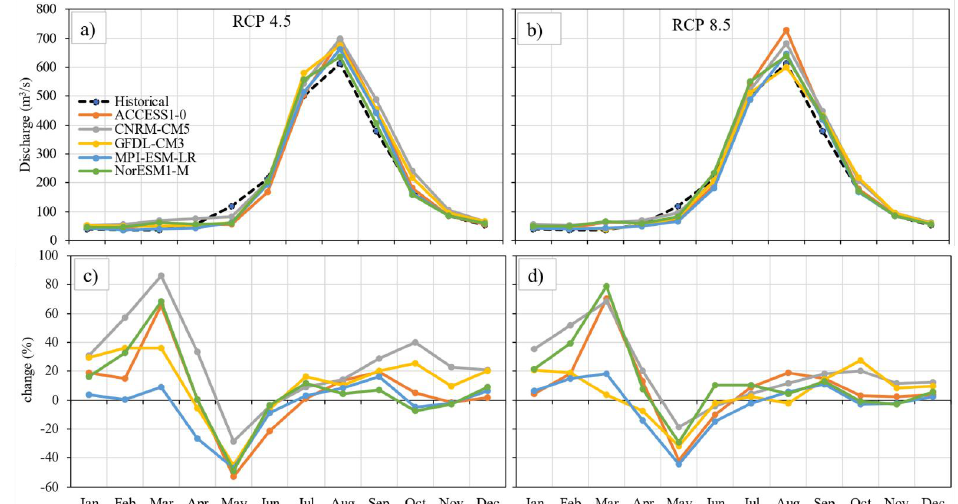
Figure 6. Monthly projection and changes in streamflow at Rimma gauge station as projected by different climate models under RCP 4.5 ( a , c ) and RCP 8.5 ( b , d ). The black dotted line in ( a ) and ( b ) represents the monthly average streamflow. ( a , c ) show the projected precipitation and percentage change in precipitation amount under the RCP 4.5 emission scenario. ( b , d ) show the same under the RCP 8.5 emission scenario. All the climate models showed an overestimated streamflow projection from July to March and an underestimated streamflow projection from May to June under RCP 4.5 and 8.5, respectively. However, a mixed tendency of overestimation and underestimation is observed by different climate models in April. GFDL-CM3 and MPI-ESM-LR projected an underestimation in streamflow simulation under both climatic scenarios, while ACCESS1- 0, CNRM-CM5, and NorESM1-M projected an overestimated streamflow. Small traces (0.3 to 0.5%) of changes in streamflow are observed as shown by ACCESS1-0 and NorESM1- M under RCP 4.5. The results show that the minimum and maximum changes in stream- flow projection are −62.4 mm (52.9%) and +32.1 mm (85.9%) under RCP 4.5. ACCESS1-0 projects the minimum change in streamflow to occur in May. In contrast, the maximum change in streamflow is projected by CNRM-CM5 in March. Under RCP 8.5, the minimum